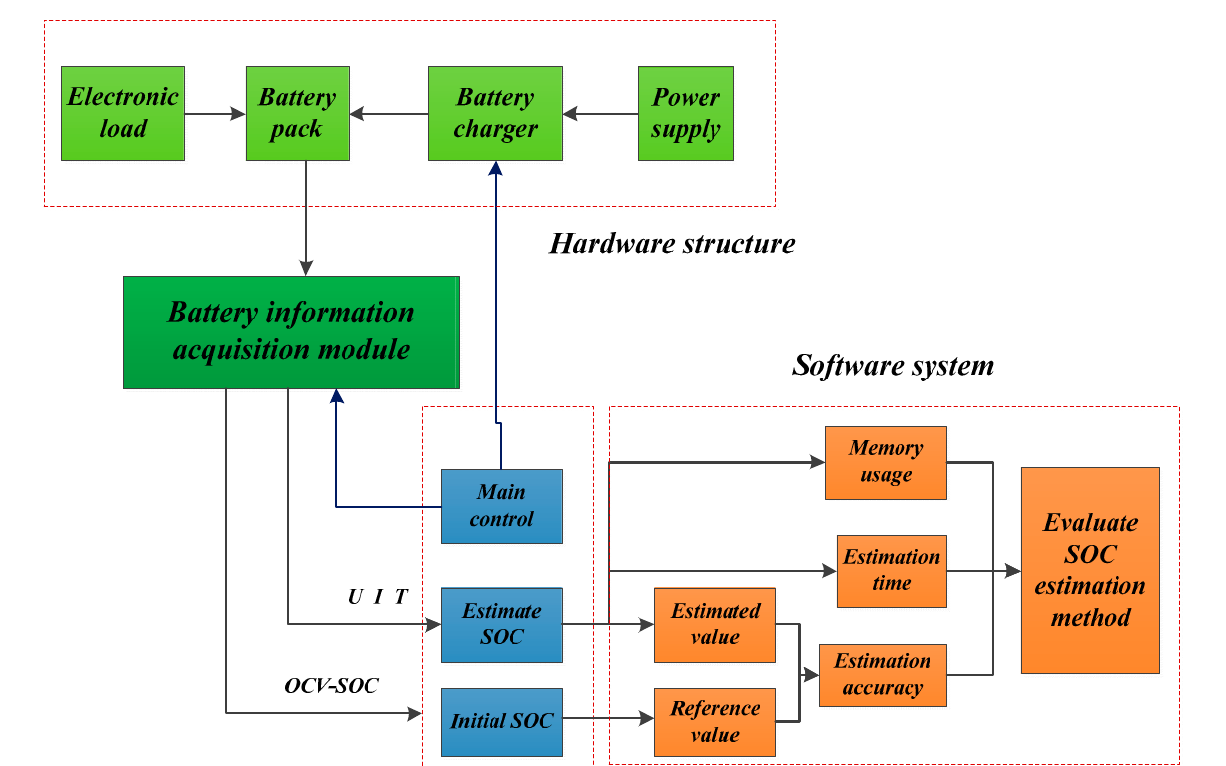
Figure 1. The overall design scheme of the verification platform.